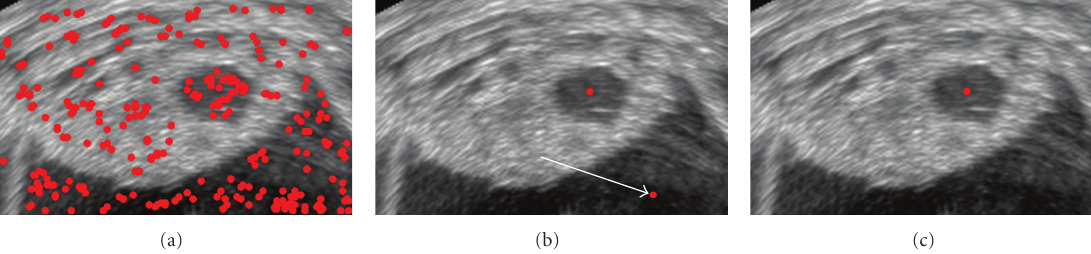
Figure 2: Follicle detection. The red dots highlight the detected minima. (a) The image shows detected minima at scale s = 2. The image is very noisy, and the algorithm detects also the minima corresponding to noisy grains (false positives). (b) The image shows minima detected at scale s = 9. The arrow shows a minimum detected outside the ovarian tissue (false positive), whereas the red dot inside the ovarian tissue corresponds to the center of a follicle. (c) In this image, the false positive outside the ovarian boundaries has been filtered out.